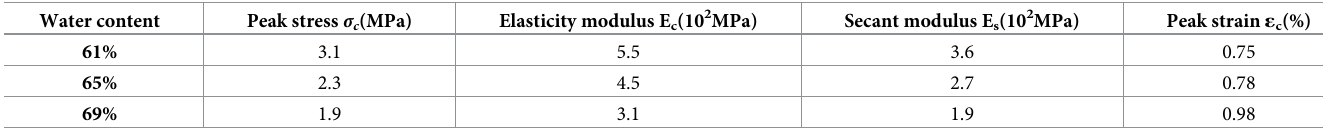
Table 1. Uniaxial compressive strength and various